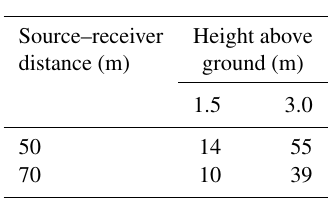
Table 3. Time difference (in sample units) between signal arrival of direct and ground-reflected wave parts for a constant and homoge- neous sound speed (temperature of 8 ◦ C,